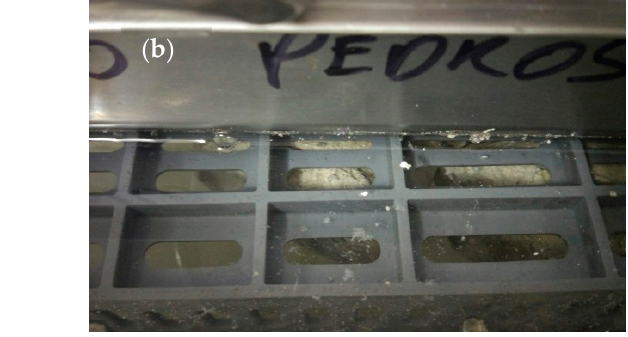
Figure 2. Aspects of the hygroscopic range evaluation ( a ) and the over-hygroscopic using a Heraeus Vötsch climatic chamber, with the samples immersed in water ( b ) in a sealed plastic box. As for the over-hygroscopic range, i.e., the amount of water that a material absorbs at 100% RH, the samples were immersed in water at 20 ◦ C (Figure 2b) in a sealed plastic box mass. The weighing occurred after carefully wiping off the sample’s surface with a damp cloth. With this, it was possible to characterise their free water saturation (w f